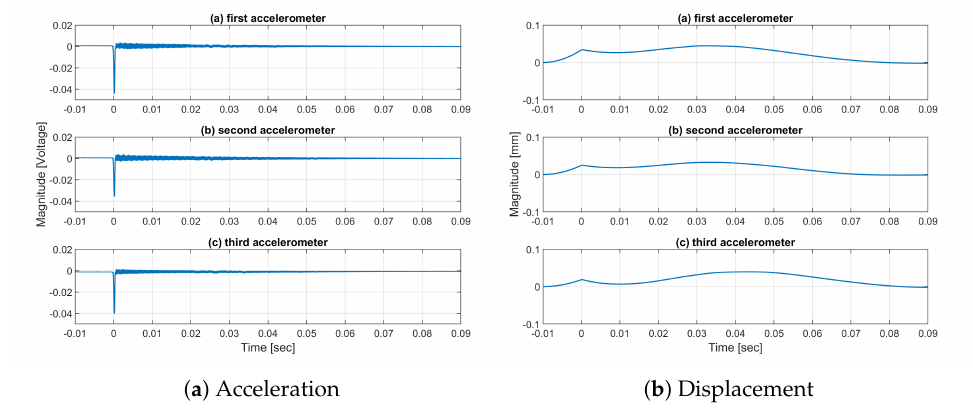
Figure 10. Typical acceleration and displacement of the new 120 grit wheel.